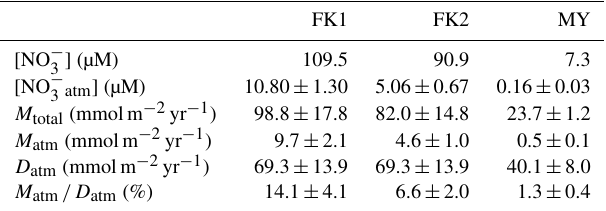
Table 2. Average concentrations of stream nitrate ([NO − the average concentrations of unprocessed NO − ([NO − ]), the annual export flux of NO − 3 atm ments ( M total ), the annual export flux of NO − catchments ( M atm ) , the deposition flux of NO − catchment ( D atm ), and the M atm /D atm ratios in the study catch- ments.